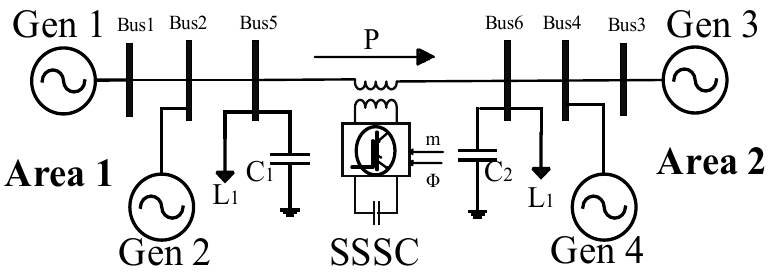
Figure 10. Two-area four-machine power system with SSSC.